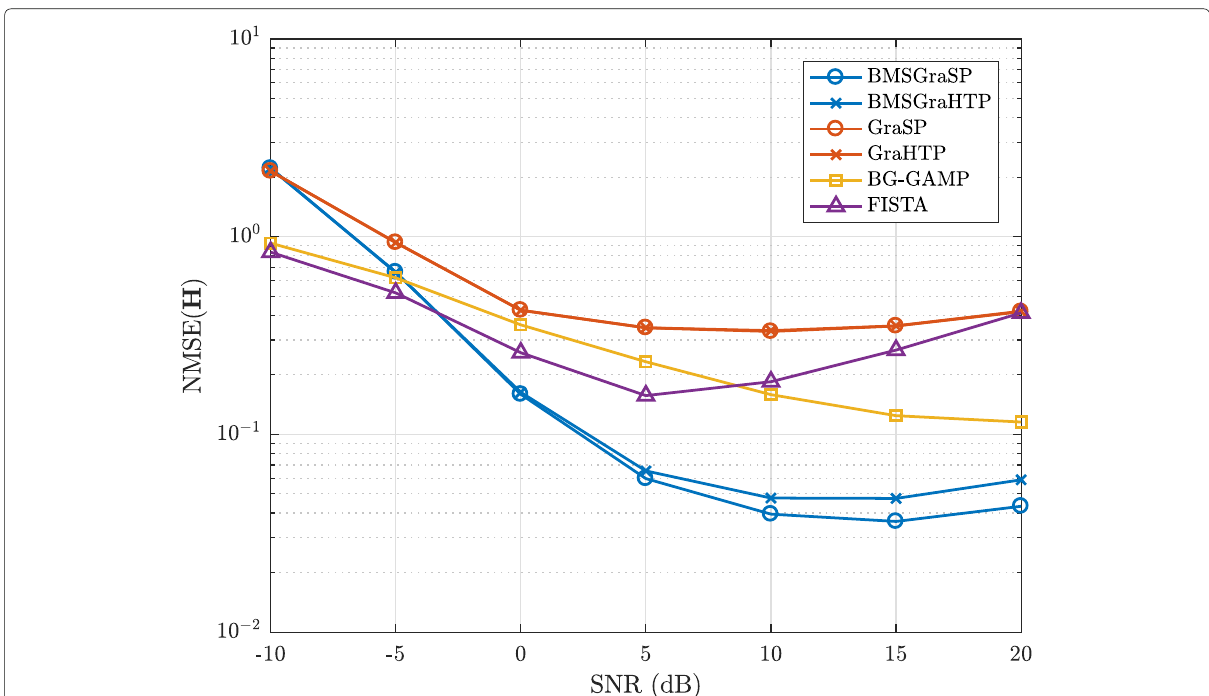
Fig. 6 NMSE vs. SNR where M = N = 64, T = 80, and L = 4 with varying B RX and B TX from algorithm to algorithm